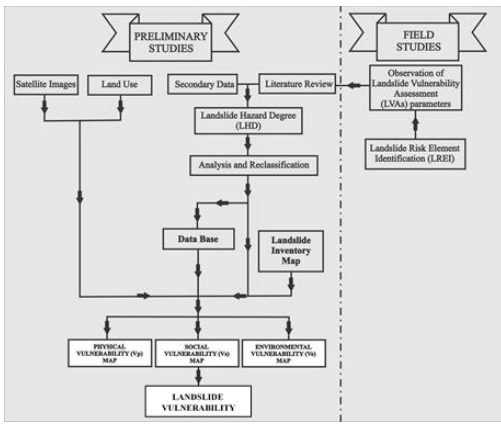
Figure 6: Landslide Vulnerability Assessment (LVAs) methods (Rodeano, 2015)